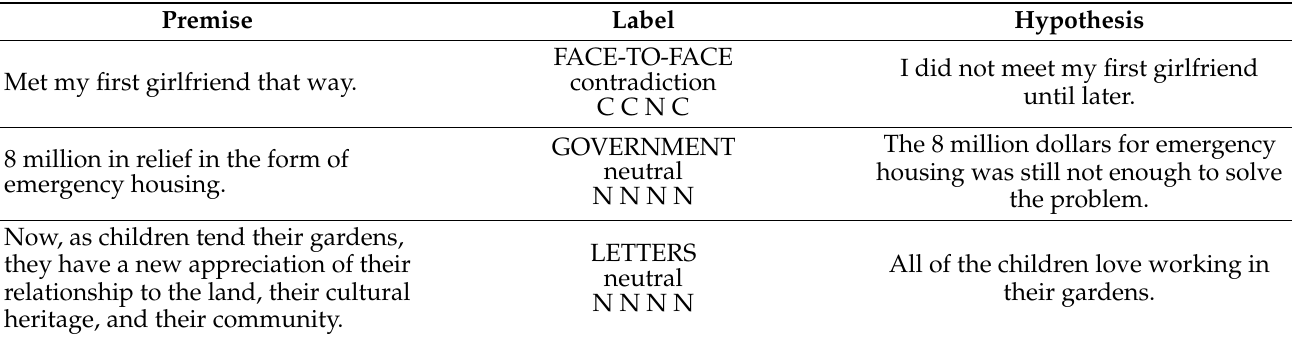
Table 5. Example data from MultiNLI